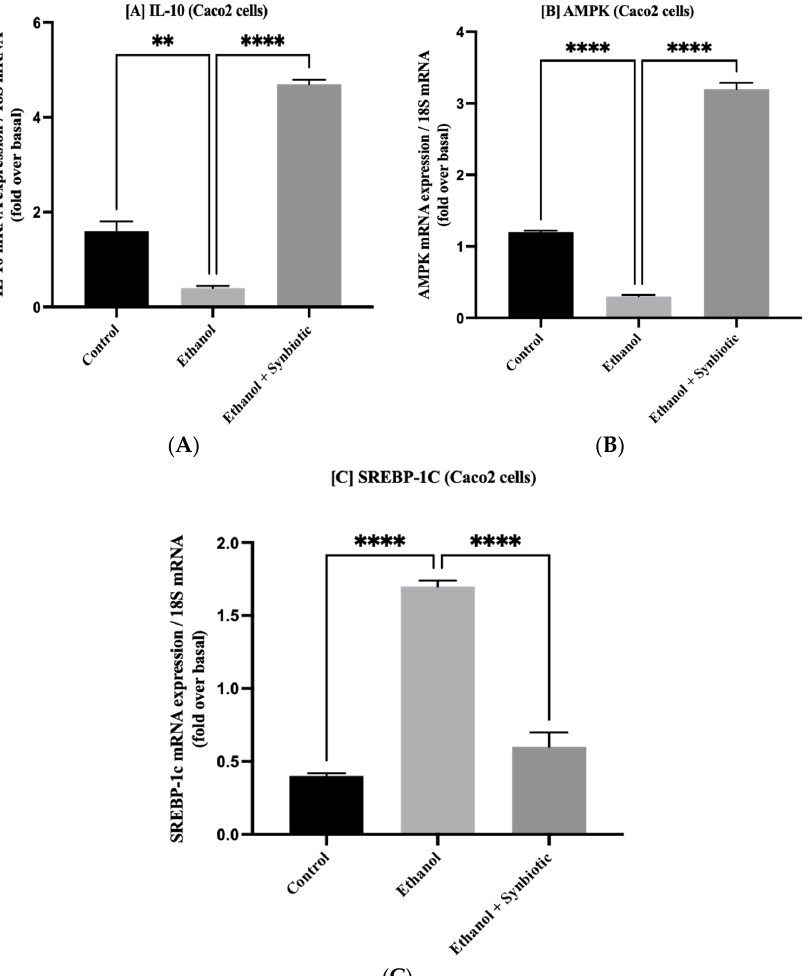
Figure 12. The mRNA expression of ( A ) IL-10, ( B ) AMPK, and ( C ) SREBP-1c in Caco2 cells is illustrated here. The anti-inflammatory markers IL-10 and AMPK were considerably increased after synbiotic (AGE + L. rhamnosus ) treatment, whereas the inflammatory marker SREBP-1c was decreased. The statistical analysis was calculated as mentioned in Section 2.10. Mean − /+ SD was determined for N = 6 replicates. For statistical analysis, GraphPad Prism 7 and one-way ANOVA in conjunction with the Tukey post hoc test were calculated. When associated with the ethanol group, significance ( p -value) is defined as ** p < 0.01, **** p < 0.0001.